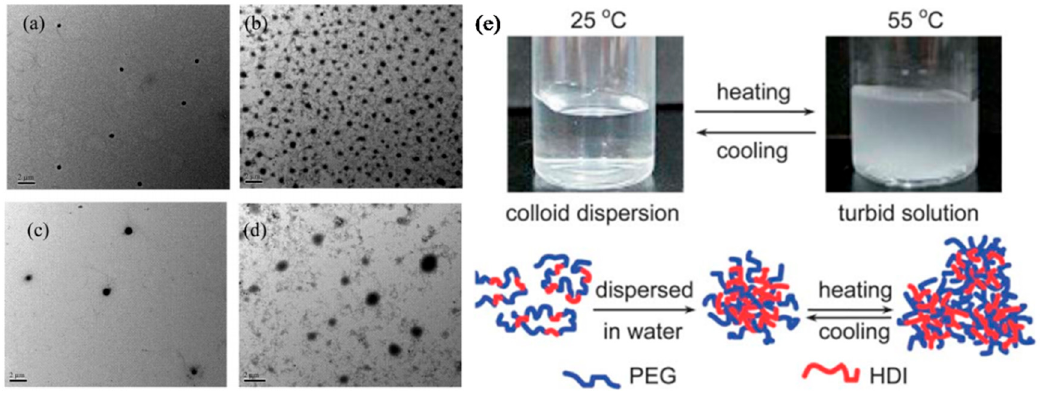
Figure 1. TEM images of LDI-PEG600 at ( a ) room temperature ( b ) 55 °C; HDI-PEG600 at ( c ) room temperature ( d ) 55 °C; ( e ) The optical pictures (upper panel) and possible aggregation process (lower panel) showing transition of HDI-PEG600 upon heating and cooling.